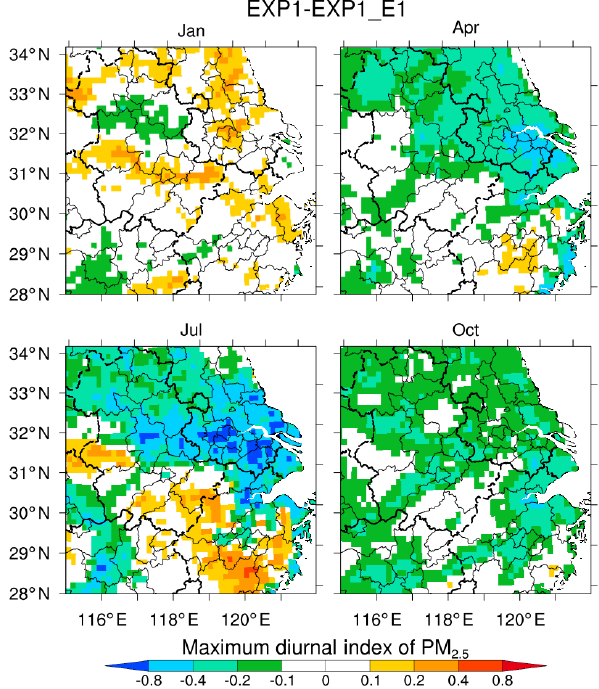
Figure 13. Spatial distribution of the difference in the daily maxi- mum diurnal index of surface PM 2 . 5 concentrations between exper- iments EXP1 and EXP1_E1 over East China in January, April, July, and October of